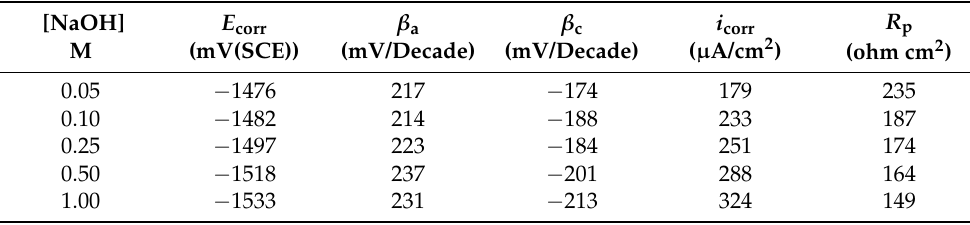
Table 1. Values of PDP parameters for Al corrosion in different [NaOH] at 298 K.